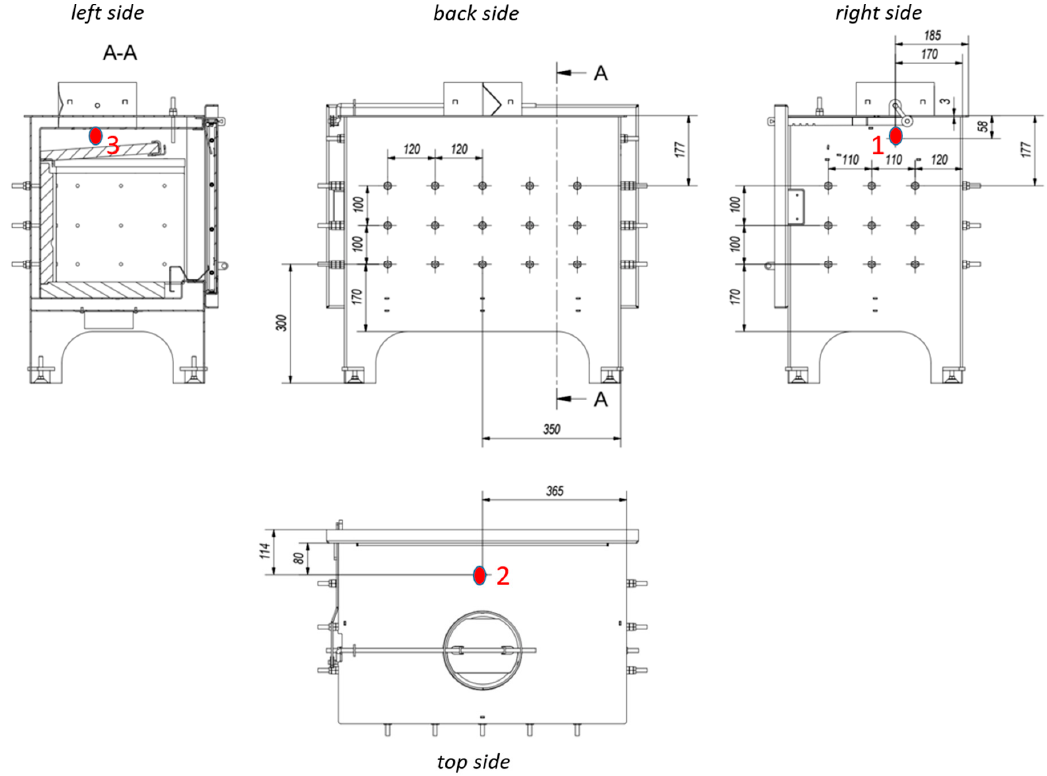
Figure 4. Diagram of three thermocouples’ placement in the fireplace insert chosen for the comparative study (Case 0).